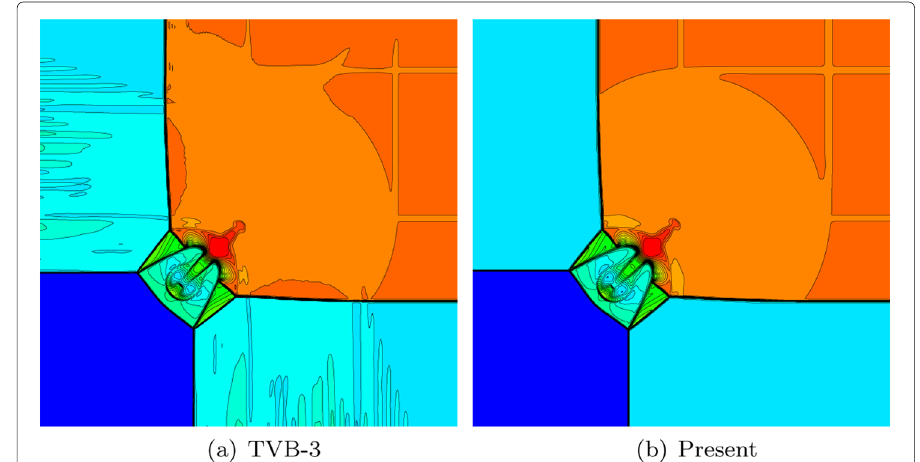
Fig. 3 Solutions (density) of the Riemann problem case for the 2D Euler equations with various indicators grid at T=0.3 under RKDG(p2) framework with S − 1 400